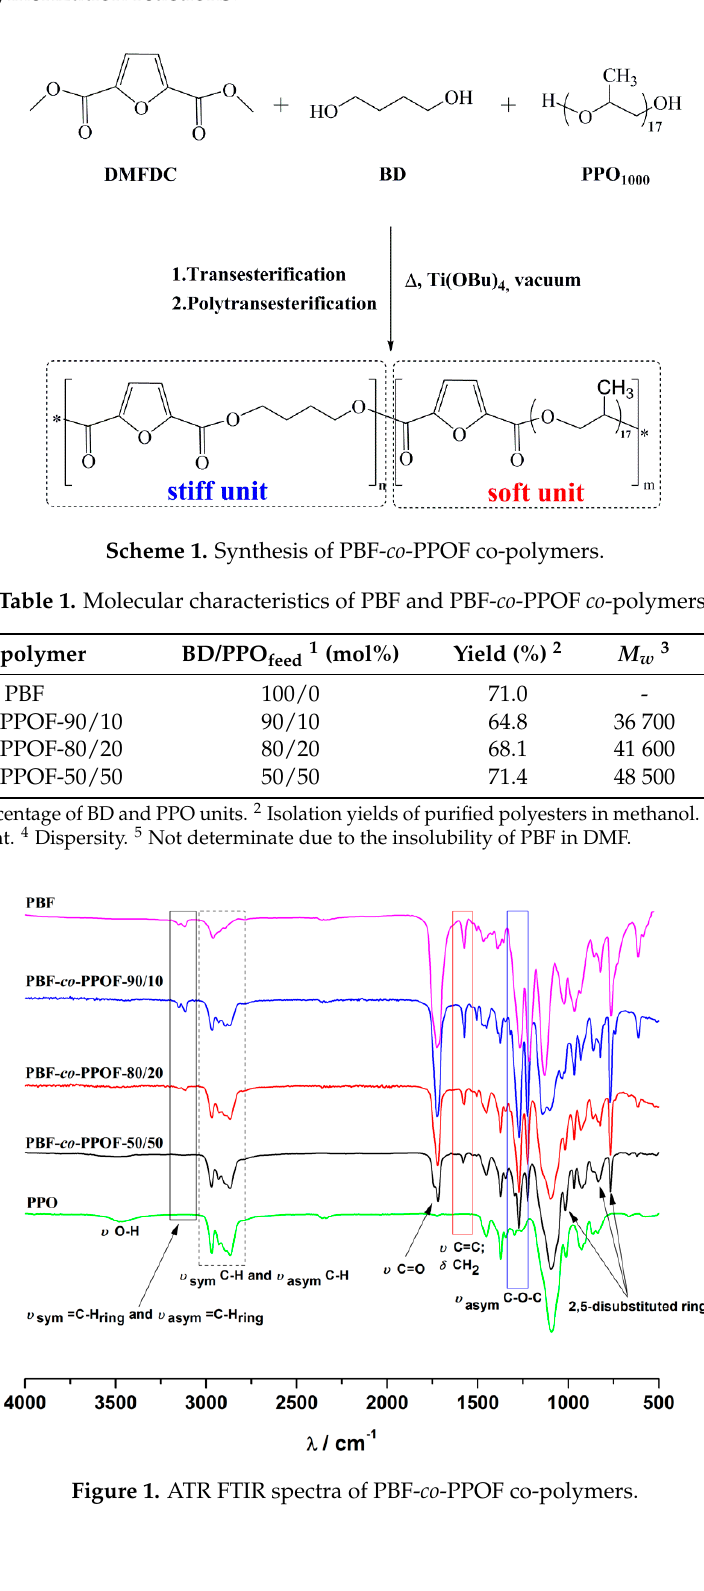
Figure 1. ATR FTIR spectra of PBF- co -PPOF co-polymers.